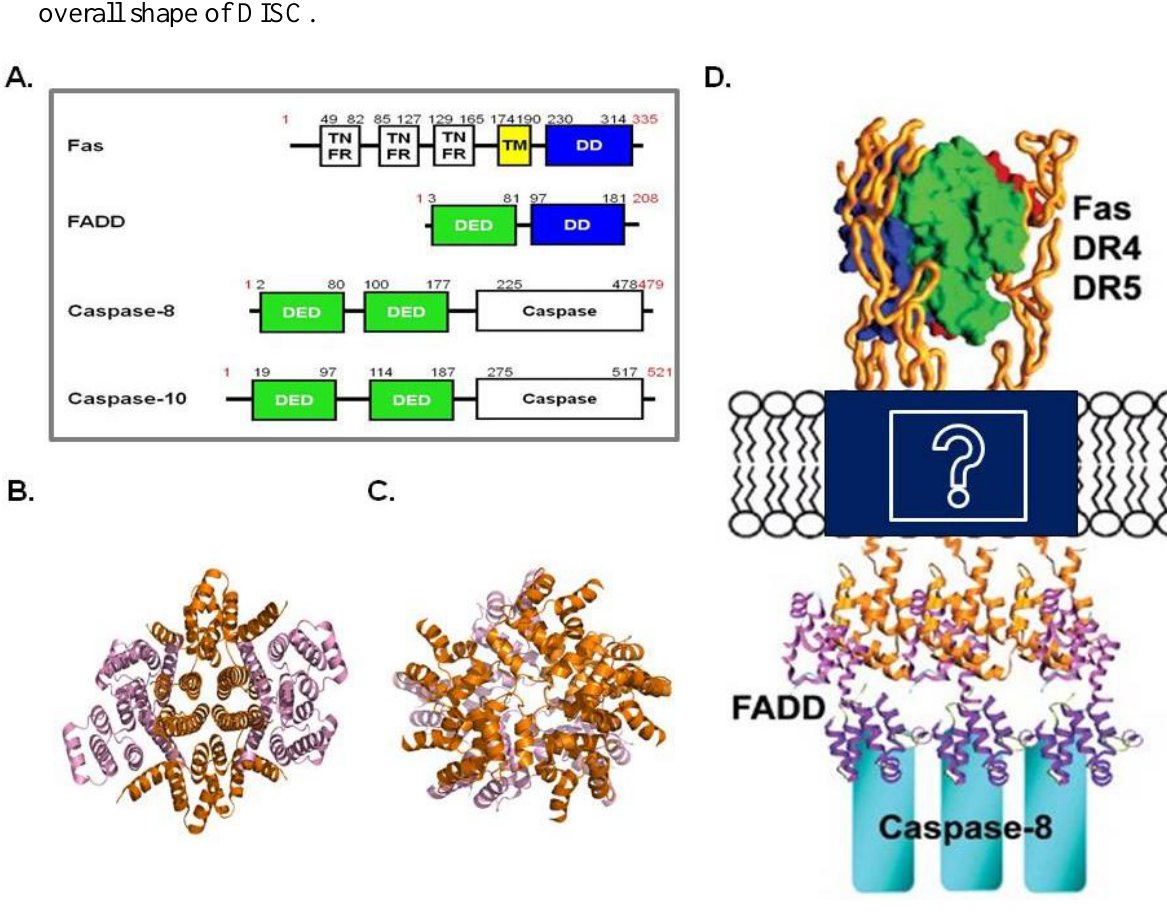
Figure 2. ( a ) Domain organization of the Death Inducing Signaling Complex (DISC) components, Fas, FADD, and caspase-8 or 10; ( b ) Overview of the Fas DD: FADD death domain (DD) complex structure solved under acidic pH conditions (Top view) (PDB id: 3EZQ). Four Fas DDs (orange color) are located inside of the complex structure and four FADD DDs (light pink color) are located outside of the complex structure; ( c ) Overview of the Fas DD: FADD DD complex structure solved under neutral pH conditions (Top view) (PDB id: 3OQ9). The top layer contains five Fas DD (orange color) and bottom layer contains five FADD DD (light pink color); ( d ) A model of the DISC for caspase-8 or 10 activation. The question mark was used to show the uncertainty in the stoichiometry and overall shape of